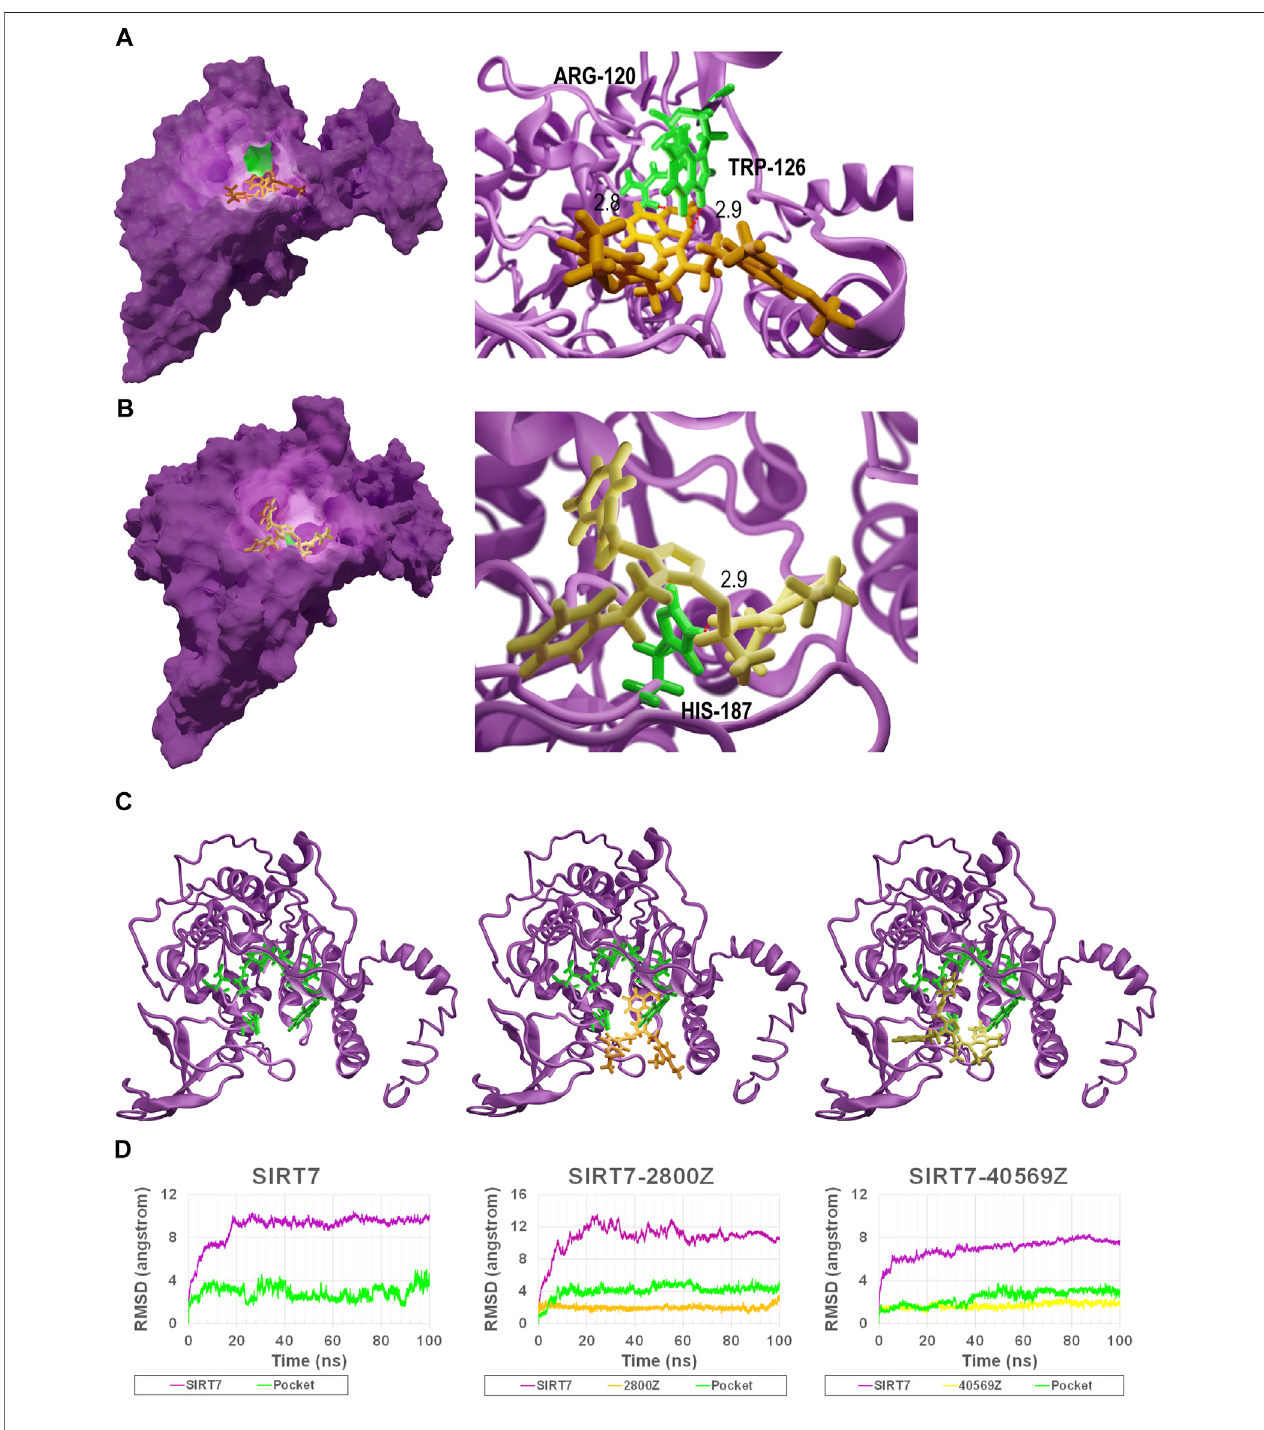
FIGURE 3 | Binding model of 40569Z-SIRT7 and 2800Z-SIRT7 complexes. (A,B) The SIRT7 – 40569Z and SIRT7 – 2800Z complex from docking: the magenta surface on the left represents SIRT7, the green surface on the left represents the key residues in SIRT7 – compound interactions, and the orange and yellow sticks represent 2800Z and 40569Z, respectively. The red dash line on the right represents the hydrogen bond. Numbers indicate the distance between compounds and residues. (C,D) RMSD for wild-type SIRT7, SIRT7 – 2800Z complex, and SIRT7 – 40569Z complex in 100 ns MD simulations. Magenta line in chart and magenta cartoon(C) indicates the SIRT7, green line in chart and green sticks (C) represent the predicted interaction pocket. Yellow sticks represent 40569Z, and orange sticks represent 2800Z.